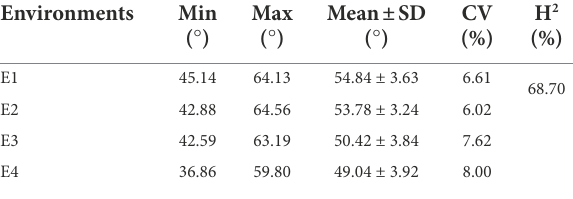
TABLE 1 Phenotypic variation of fruit branch angle (FBA) in four